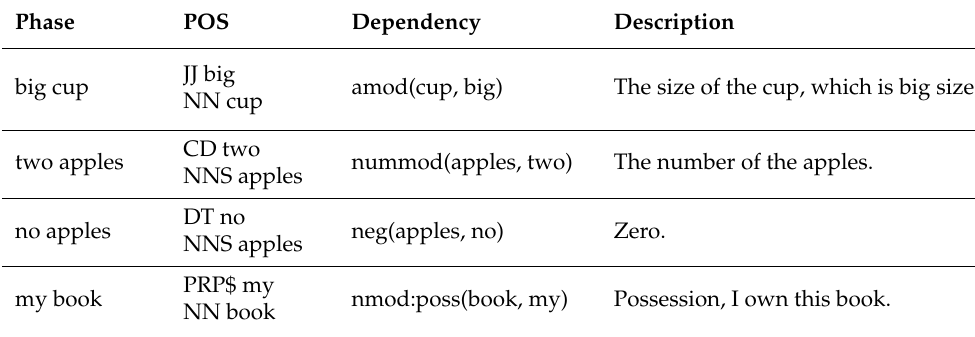
Table 1. Some modifier